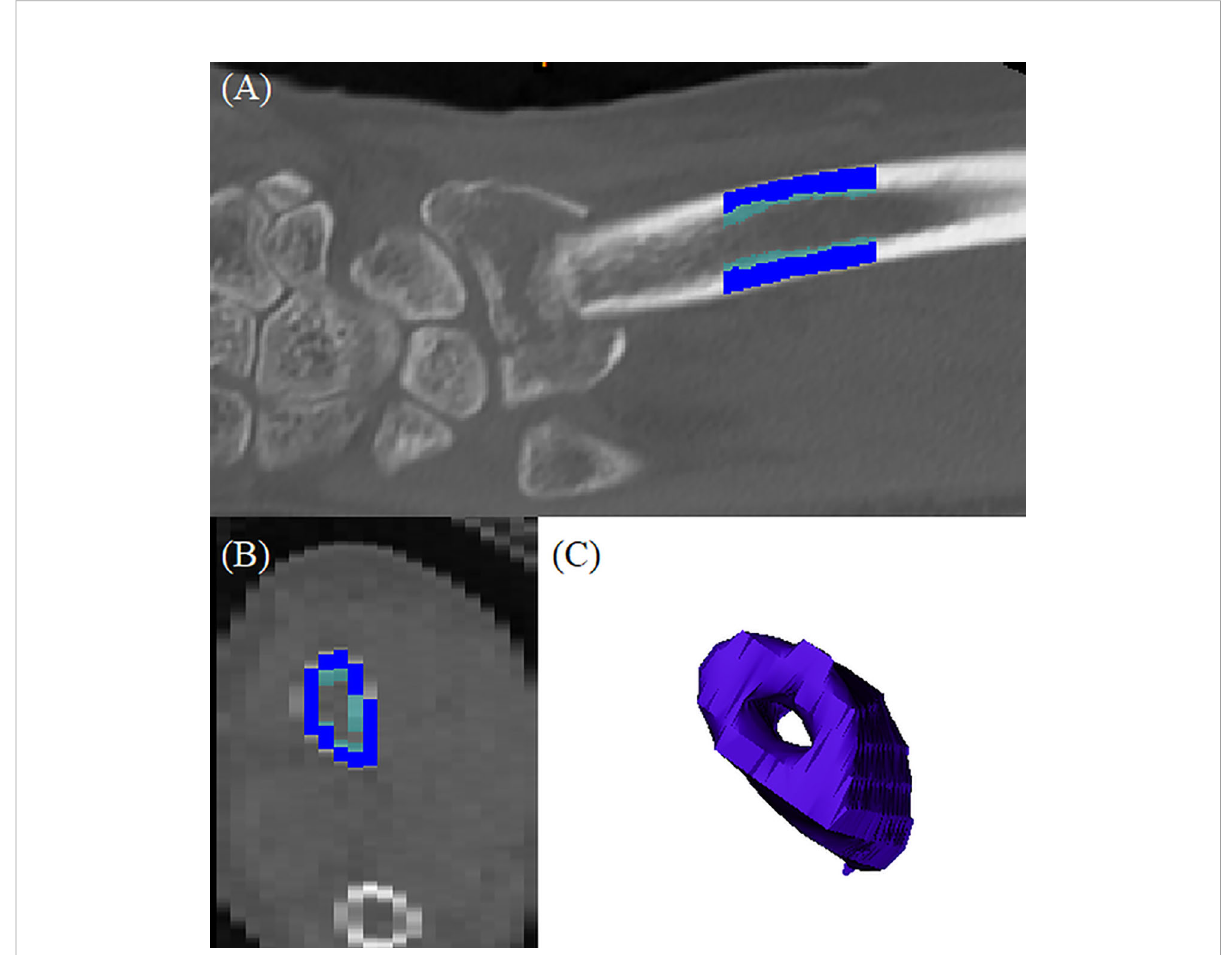
FIGURE 1 3D reconstructed distal radius bone model: (A) coronal section of the original CT images; dark blue indicated cortical bone and light blue indicated trabecular bone, (B) axial section of the original CT image; dark blue indicated cortical bone and light blue indicated trabecular bone, (C) reconstructed bone